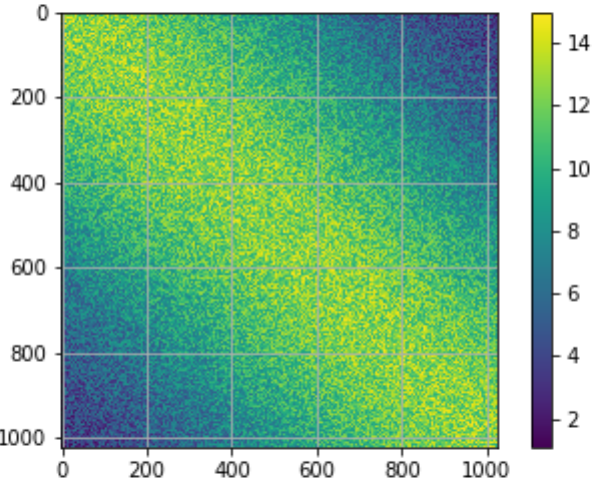
Figure 2. Gaussian test image of about 1000 × 1000 pixels generated artificially with a rapidly varying stochastic object field over the z - x pixel plane. The y height field is in arbitrary test units. Trees on the ground can be defined by their scatter probability density function p ( x , z )